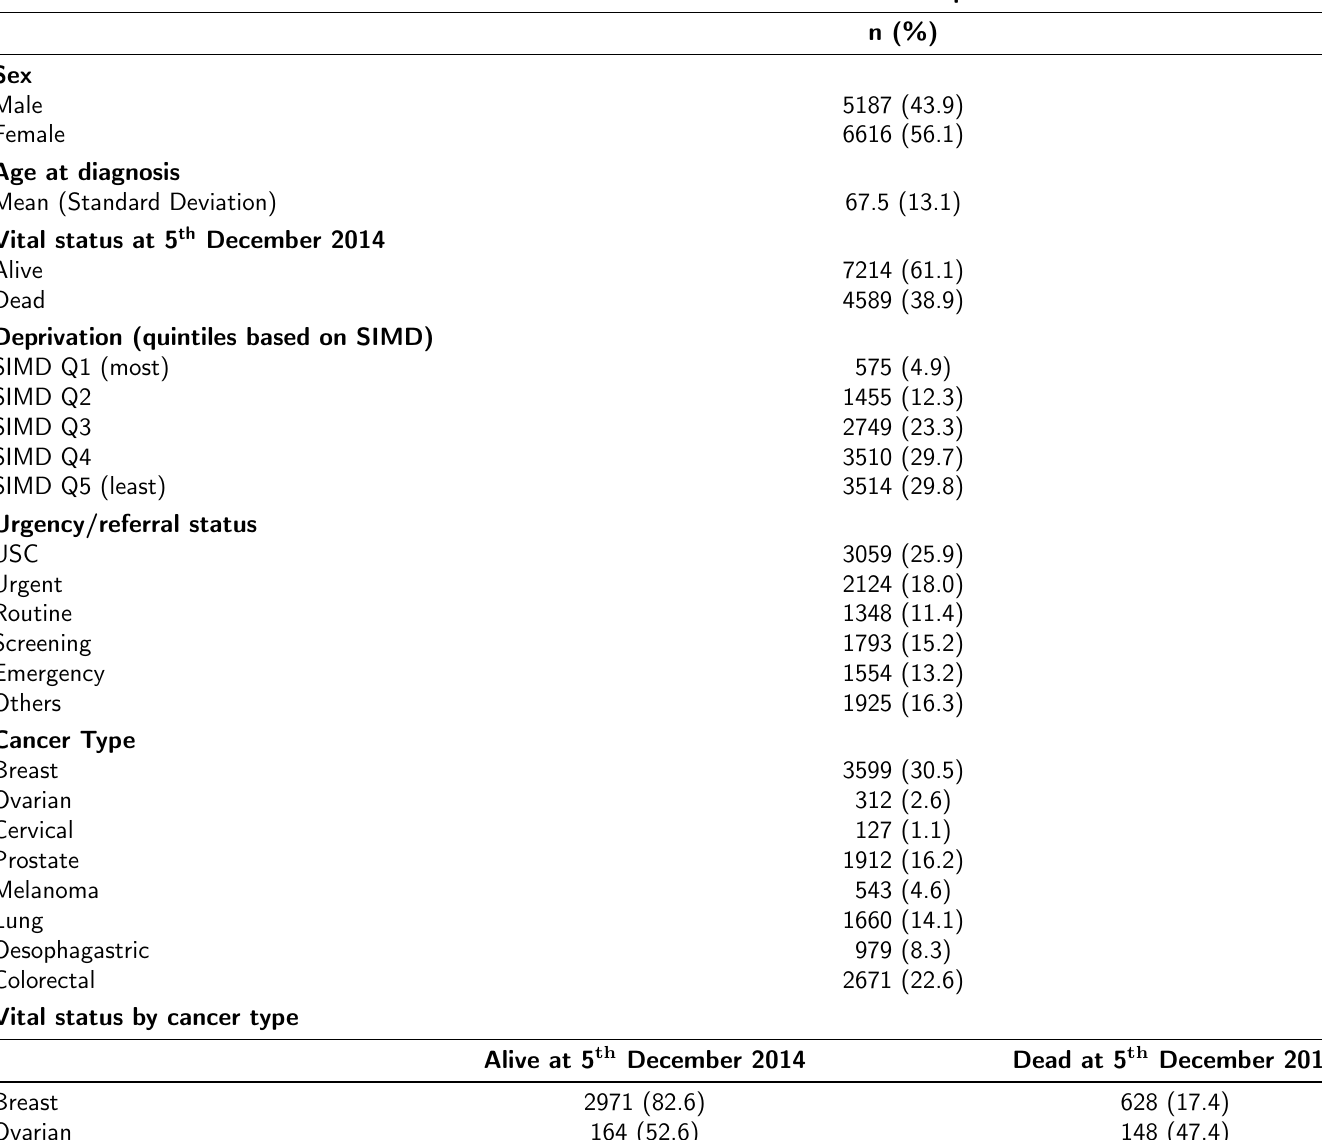
Table 1: Patient and pathway characteristics at time of referral (12339 patients in NASCAR, 401 could not be matched to